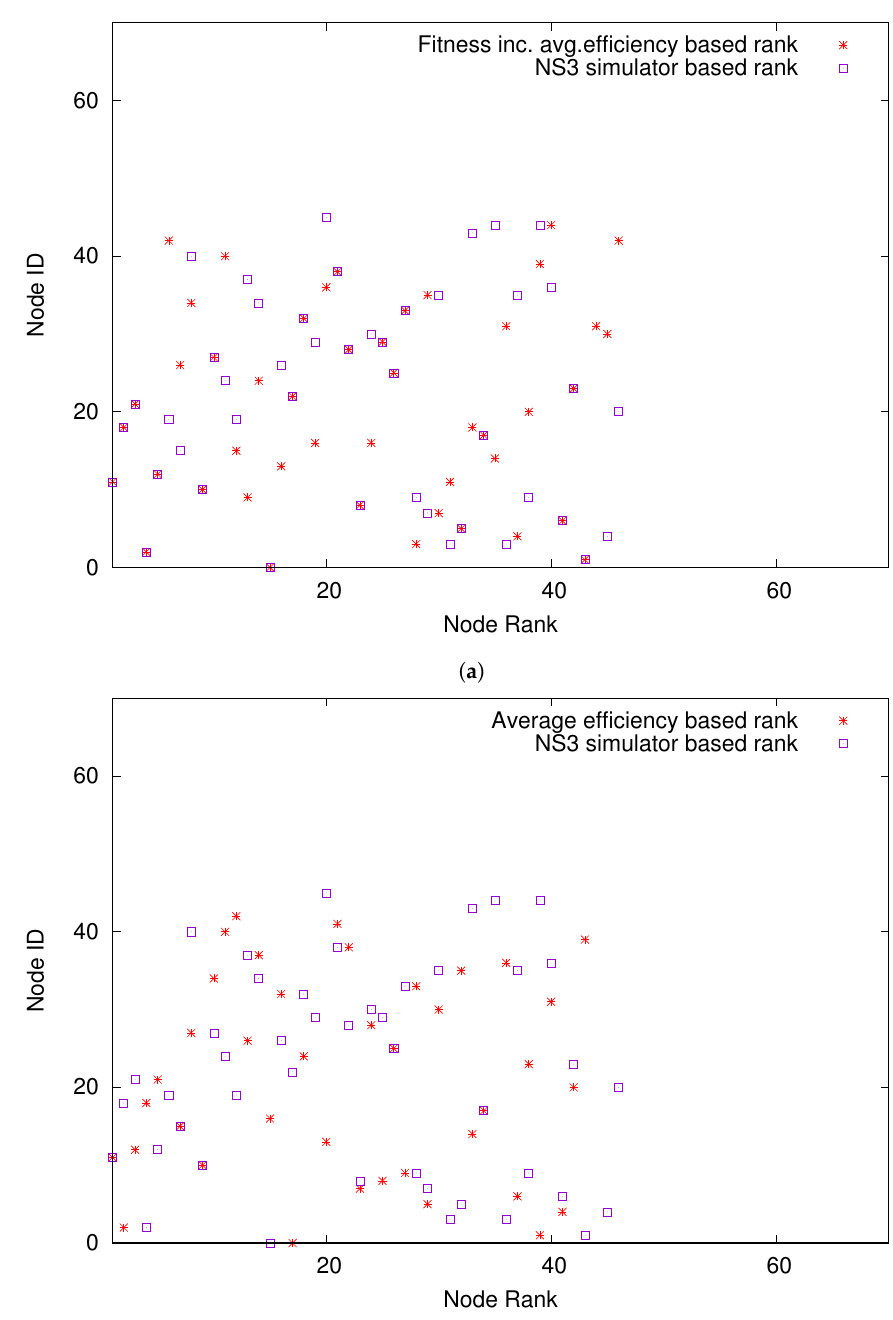
Figure A3. Node ranking comparison for scale-free topology, when the fitness is distributed in a manner that correlates with the degree. ( a ) Fitness incorporated average efficiency-based ranking vs. NS3 simulator ranking. ( b ) Average efficiency-based ranking vs. NS3 simulator-based